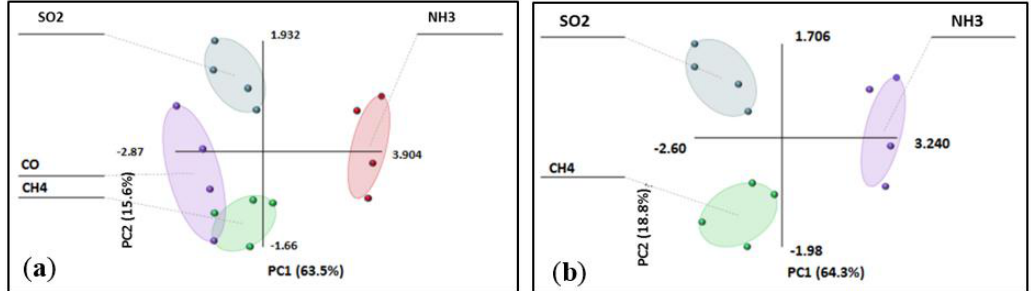
Figure 3. Principal component analysis of sensor array response to ( a ) CH 4 , CO, SO 2 and NH 3 ; ( b ) CH 4 , SO 2 and NH3. SO 2 and NH 3